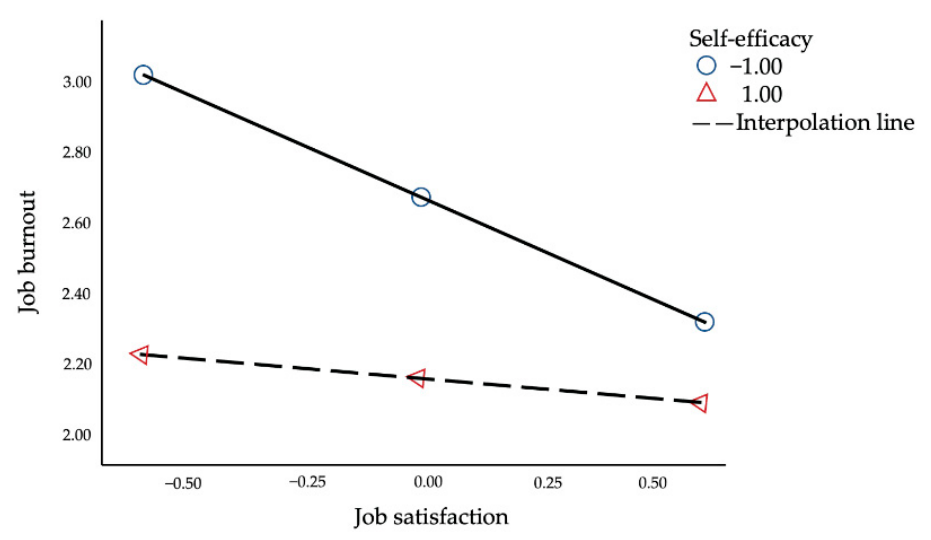
Figure 4. Simple plot image.